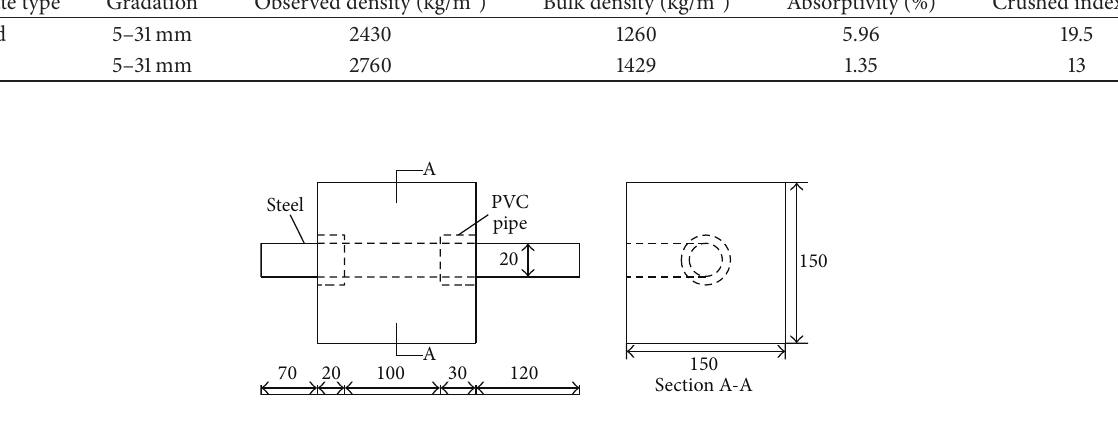
Figure 1: Geometry of the fabricated specimens; all units in